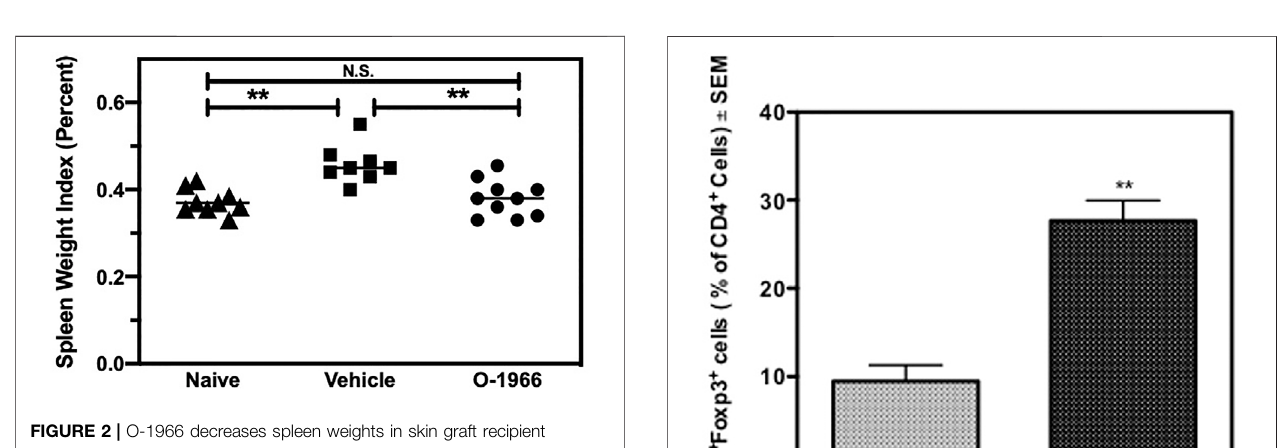
FIGURE 1 | O-1966 treatment prolongs skin graft viability. Donor C3HeB/FeJ fl ank skin was transplanted to the back of a recipient C57BL/6J mice, sutured, and bandaged.DosesofO-1966orvehicle (0.03%ethanoland0.03%cremophorinsaline)wereinjectedi.p.everyotherday,from1 hpre-op to14 dayspost-op.Onday7 bandageswereremovedandgraftsweremonitoredforrejection.Percentgraftsurvivalofmicetreatedwith (A) 1 mg/kgO-1966 ( ) ,orvehicle ( ) , (B) 5 mg/kgO-1966 ( ) orvehicle ( ) ,or (C) 10 mg/kg O-1966 ( ) orvehicle ( ) .Panels (A,C) areresults ofasingleexperiment(n (cid:1) 8per group), anddatainPanel (B) arethemean of two experiments (n (cid:1) 17 per group). Median survival time of vehicle vs. O-1966 treatment at 5 mg/kg, ** p < 0.001 by the Log rank [Mantel-Cox] test.